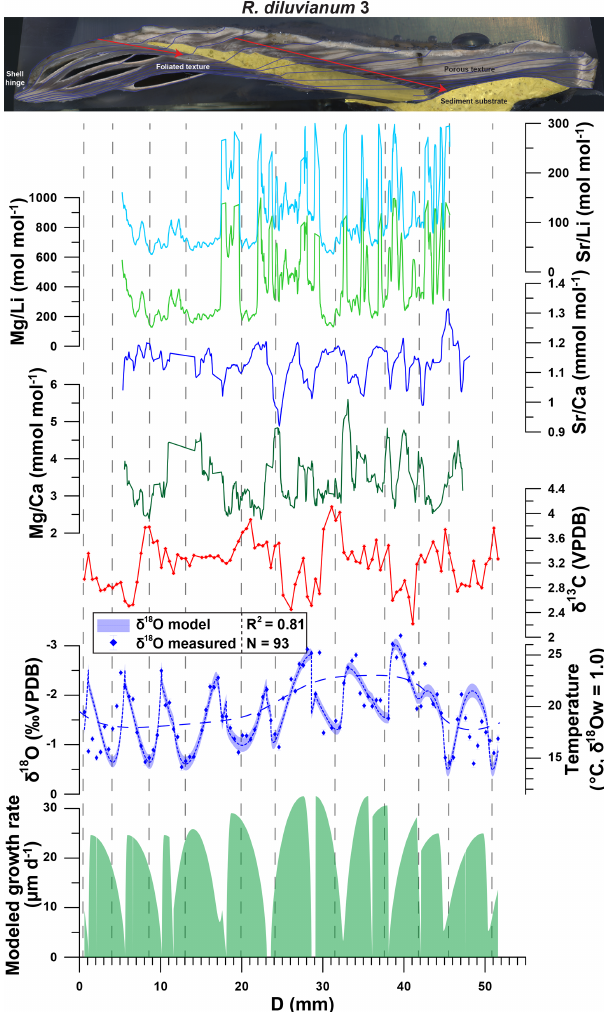
Figure 7. Example of multi-proxy records measured in R. dilu- vianum specimen 3 plotted against distance in growth direction (see image on top and Fig. 3 for reference). From top to bottom, records of Sr / Li (light blue), Mg / Li (light green), Sr / Ca (dark blue), Mg / Ca (dark green), δ 13 C (red), δ 18 O (blue dots with error bars) and modeled growth rate (light green shading) are plotted. The shaded blue curve plotted underneath the δ 18 O record illustrates the result of growth and δ 18 O modeling and its propagated error (ver- tical thickness of curve, 2 SD). The dashed blue curve plotted on top of the δ 18 O record shows the observed multi-annual trend in the data. Vertical dashed lines separate growth years. Multi-proxy plots for all specimens are given in Fig. S10 from de Winter et al.